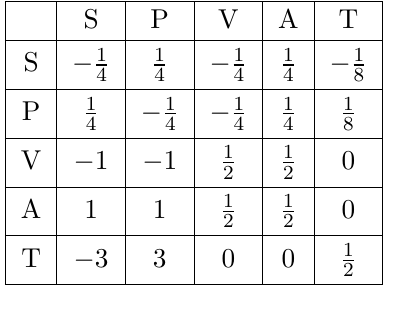
Table 11 . Fierz identities for (cid:0) = (1 ; i(cid:13) 5 ; (cid:13) (cid:22) ; (cid:13) (cid:22) (cid:13) 5 ; (cid:27) (cid:22)(cid:23) = i